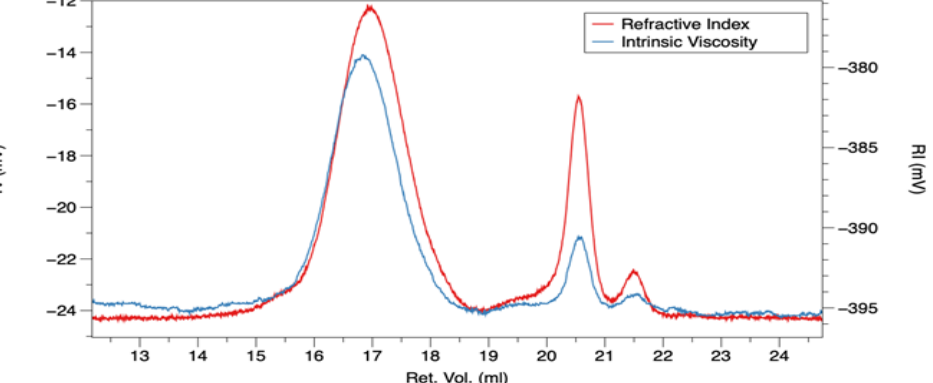
Figure 1. Gel permeation chromatography (GPC) profile of artichoke roots inulin, considering the refractive index (red line) and the intrinsic viscosity (blue line).